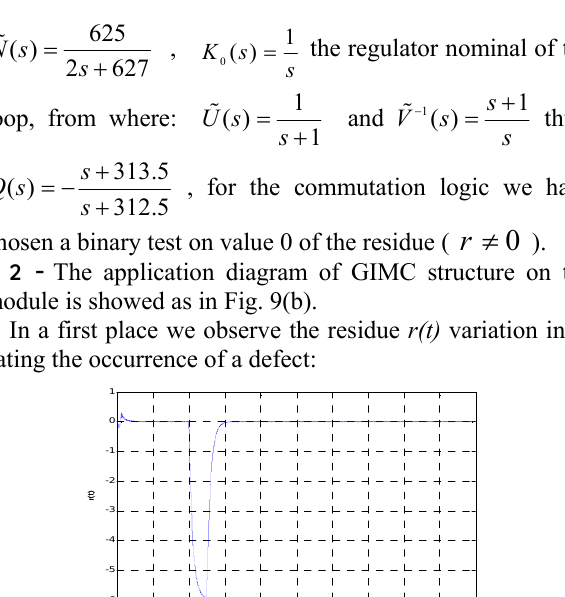
Fig.10. Residue variation r(t)